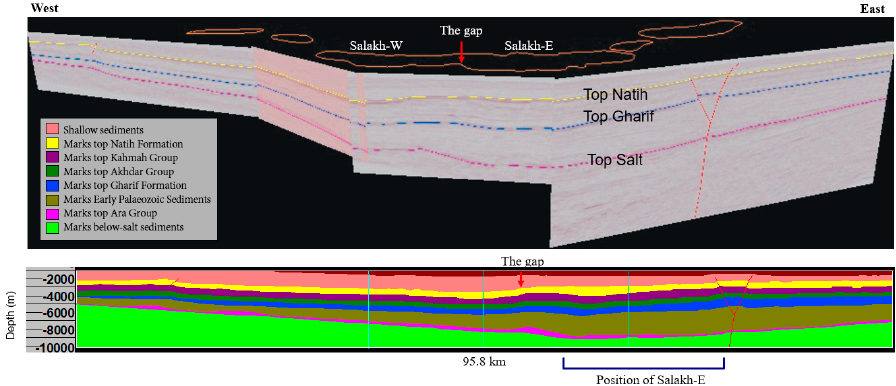
Figure 11. Four seismic lines, forming composite seismic section 1, in depth were used to create an arc-parallel seismic section that shows the thickness of the formations on the southern side of the arch. The section shows that the saddle between the Salakh E and Salakh W structures coincides with an abrupt change of the Haima Supergroup thickness (from Gharif to Ara Salt reflectors). Also, the Salakh E structure developed at the location of the thickest zone of the Haima Supergroup in the entire arch.